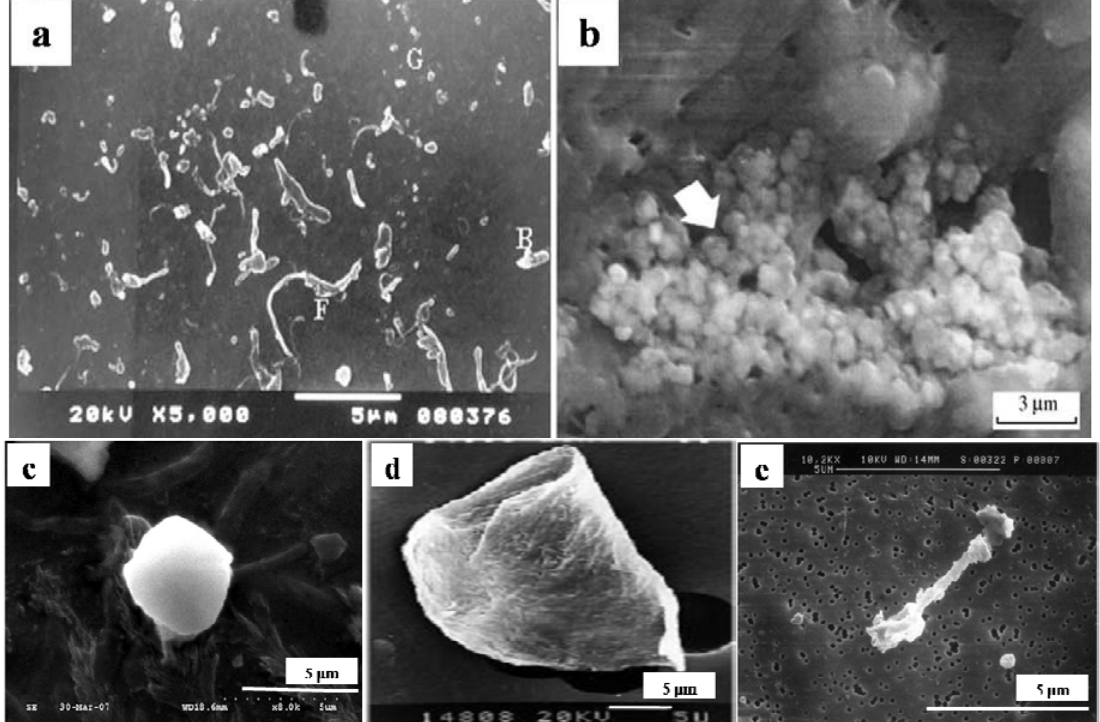
Figure 4. Typical morphologies of wear debris from periprosthetic tissue; ( a ) UHMWPE [90]; and ( b ) Alumina [103]; ( c ) Spherical (UHMWPE) [34]; ( d ) Sheet/Flake type (UlHMWPE) [112] and ( e ) Fibril (UHMWPE)